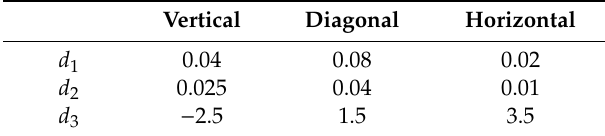
Table 5. J–C failure parameters identified on tensile tests for di ff erent build directions. Vertical Diagonal Horizontal